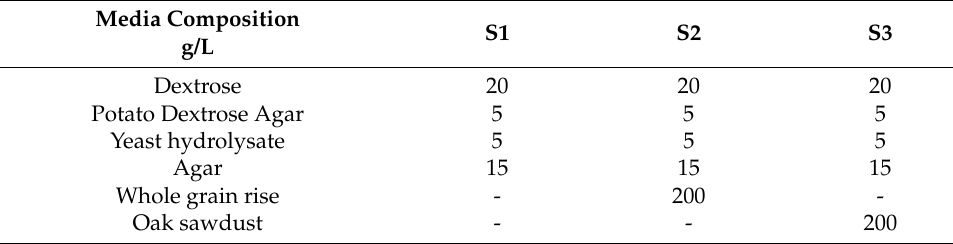
Table 2. Media composition of solid culture for mycelium